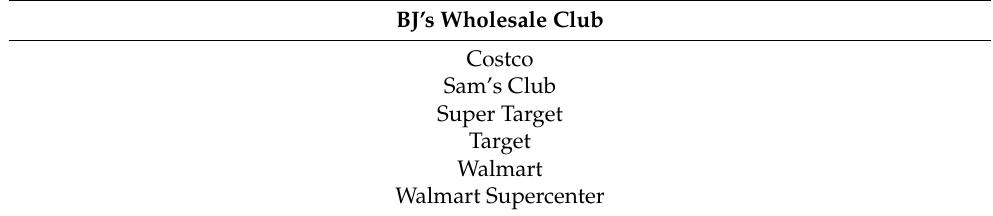
Table A2. A list of department stores (NAICS: 452,210) considered as healthy food retailers.